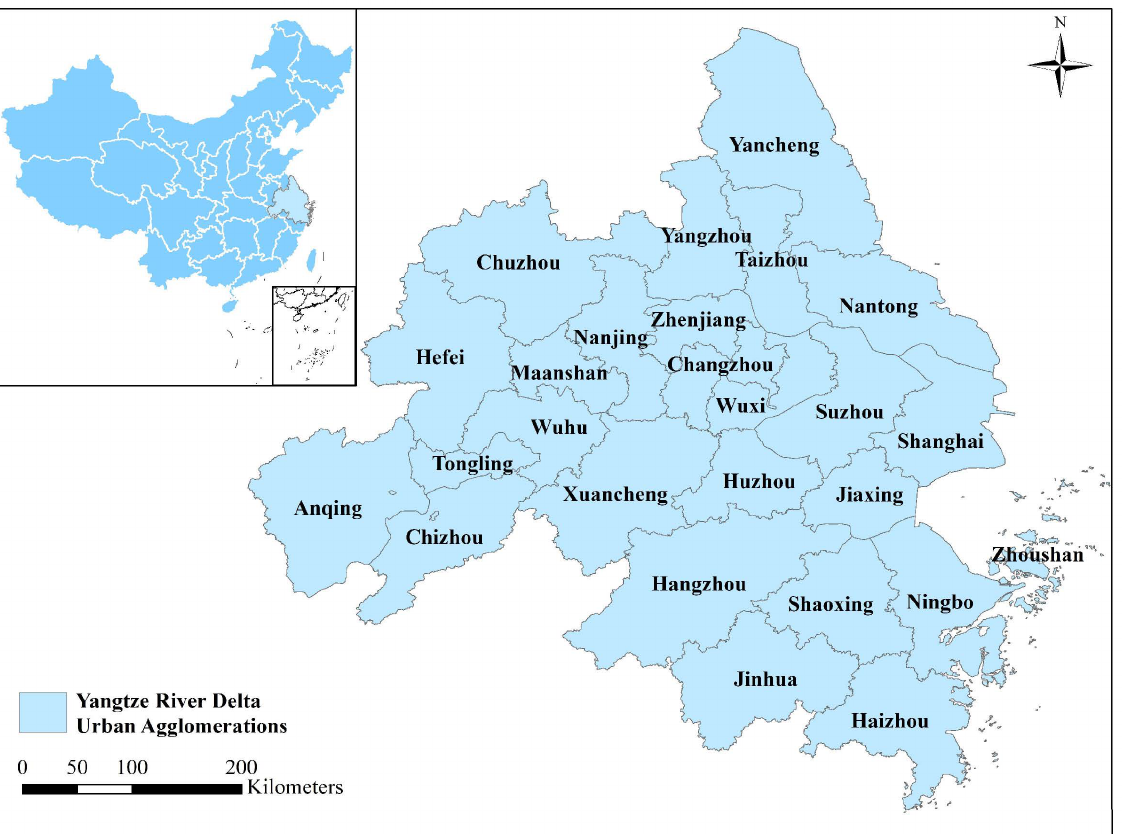
Figure 1. The Yangtze River Delta urban